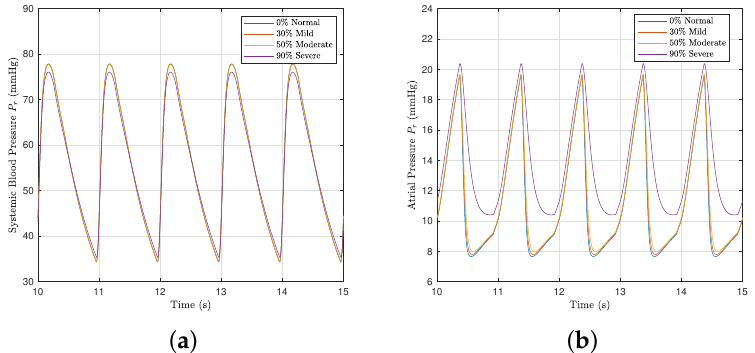
Figure 2. The systemic and atrial pressures with different severities of mitral valve stenosis. ( a ) Systemic blood pressure P s . ( b ) Atrial pressure P r .